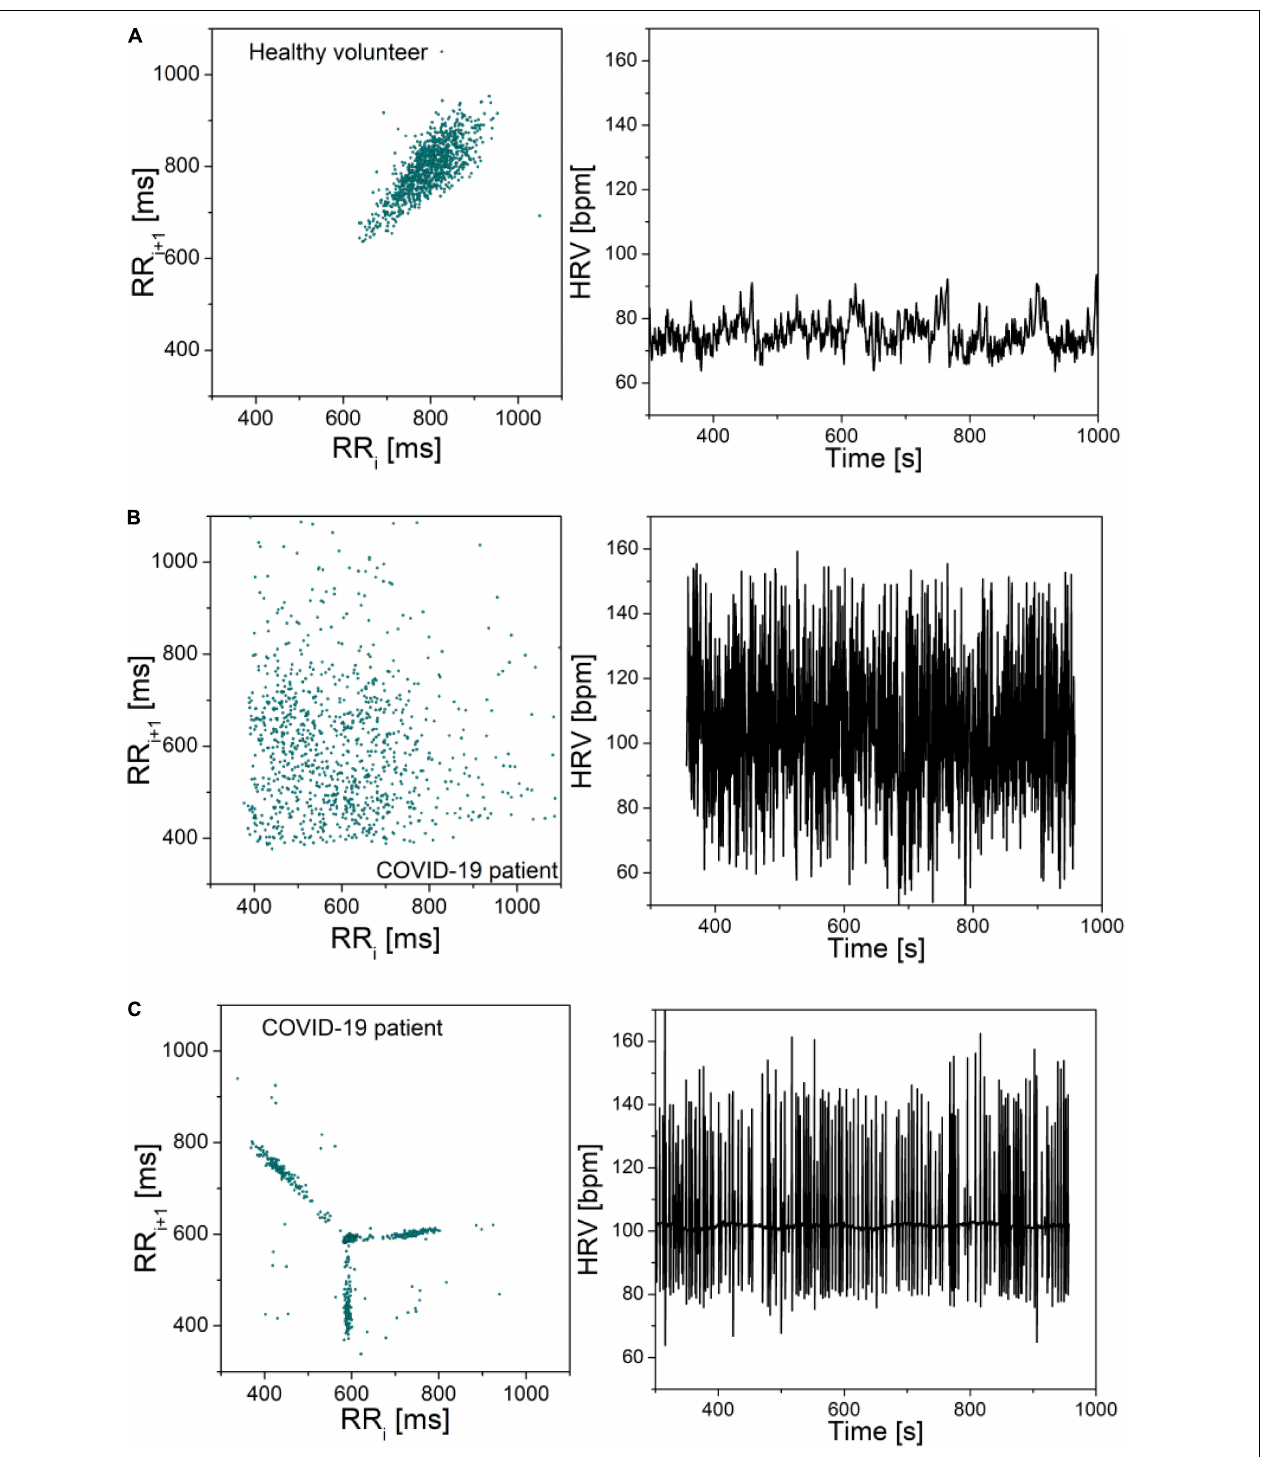
FIGURE 3 | Poincare plots and corresponding heart rate signals: (A) Healthy volunteer; (B) COVID-19 patient; (C) COVID-19 patient. Note that the scale is the same in all graphs. The plots are included to illustrate the adverse effects of COVID-19 infection, but the signals were not part of the presented statistics. Patient (b) is male, 71 years old, height 168, weight 66. The patient reported no hereditary diseases, gait instability, and last 2 months the patient was experiencing hard breathing. During hospitalization it was discovered that the patient has heart valve disease, before that the patient was healthy. Patient (c) is female, 87 years old, height 163, weight 81. She reported problems with spine, occasional headaches, dizziness when changing her head position, no hereditary diseases and no other health problems.